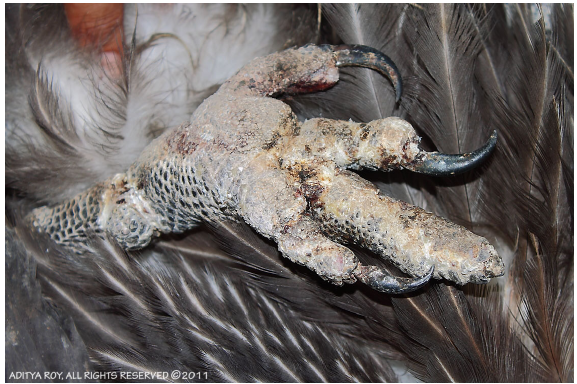
Image 10. Leg infection from E. coli